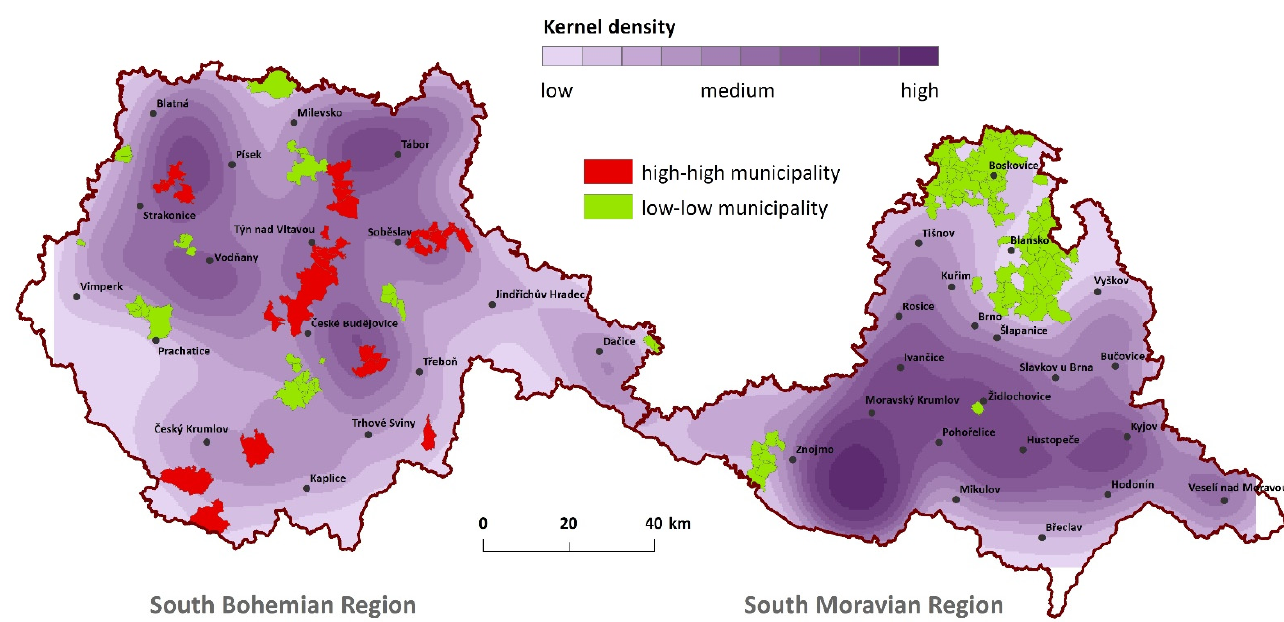
Figure 3. Location of the clusters of regions with a high-high (red) and low-low a (green) occurrence of the long-term